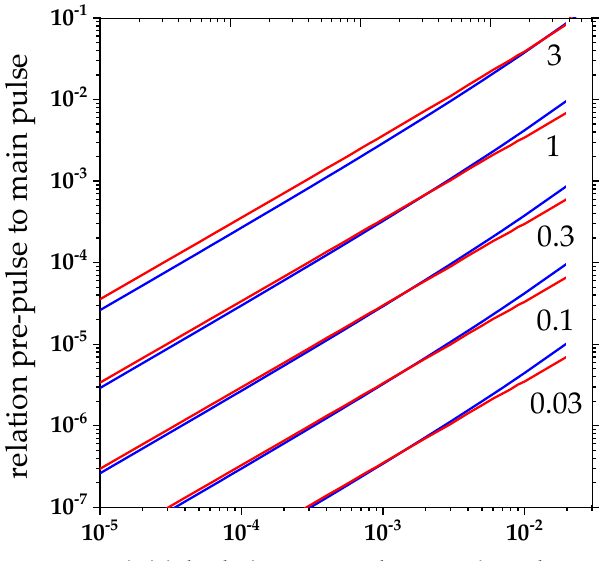
Figure 3. Validation of numerical simulation. We calculated with our model for di ff erent B-integral values (label on right side) and relative post-pulse magnitudes the resulting relative pre-pulse strength (red). For comparison, the same values were analytically calculated using Equation (1) (blue).